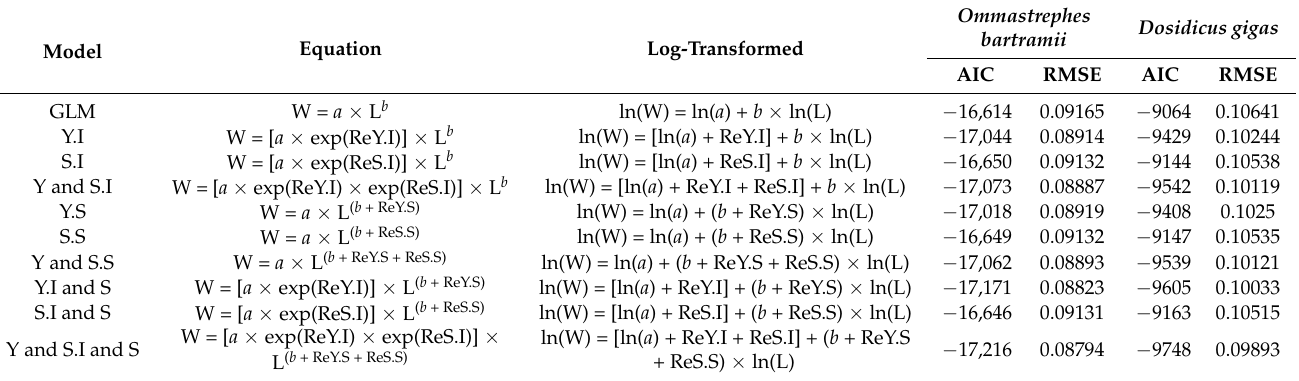
Table 2. Models for length–weight relationship of two ommastrephid species and its fitting